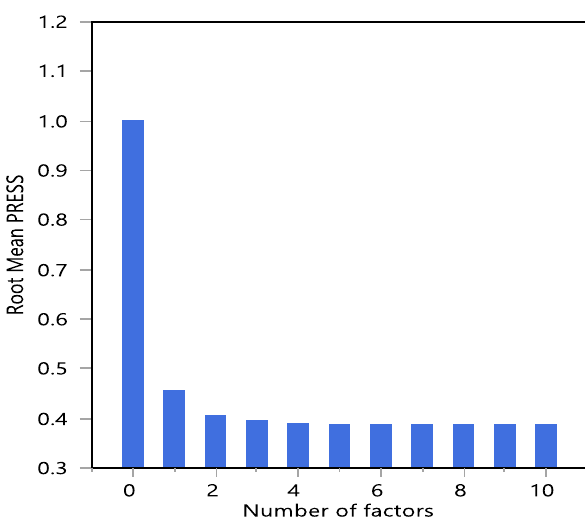
Fig. 6 Number of latent factors versus root mean PRESS for volume loss model